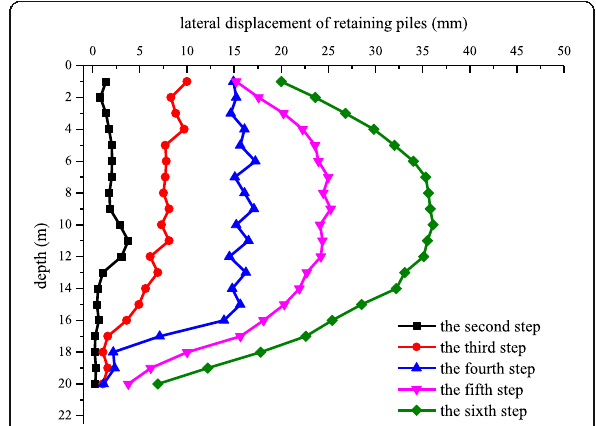
Fig. 6 Monitored lateral displacement of retaining piles of